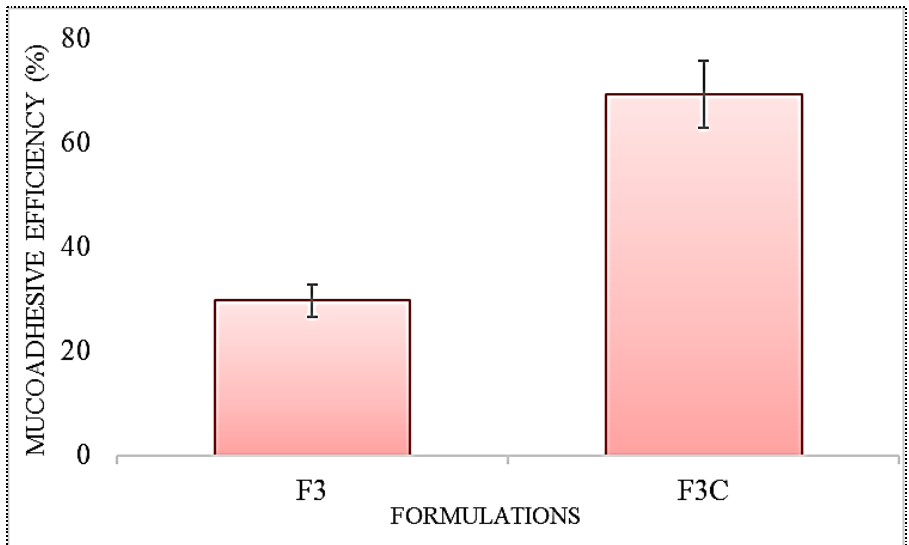
Figure 3. Mucoadhesive efficiency study results of IPI vesicles (F3) and chitosan-coated IPI vesicles (F3C). The results shown in triplicate and data shown as mean ± SD.